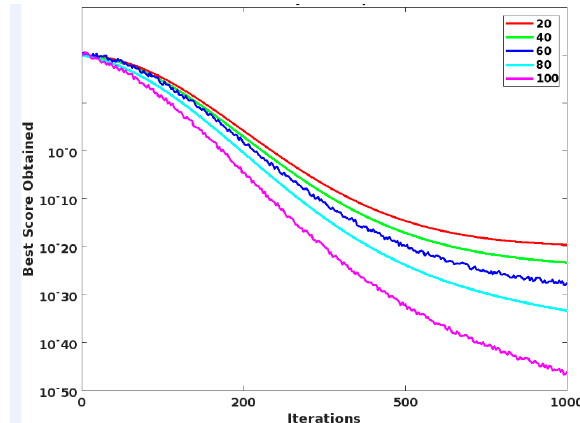
Figure 6. Convergence analysis of ZESO.